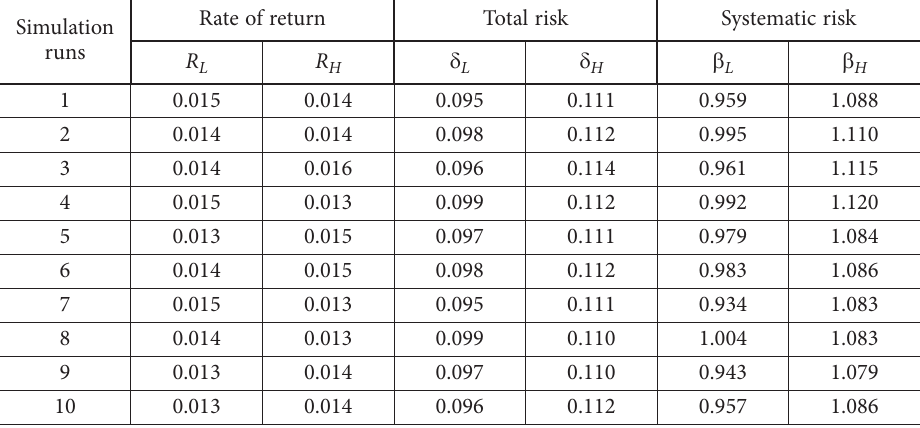
Table 4. Simulation